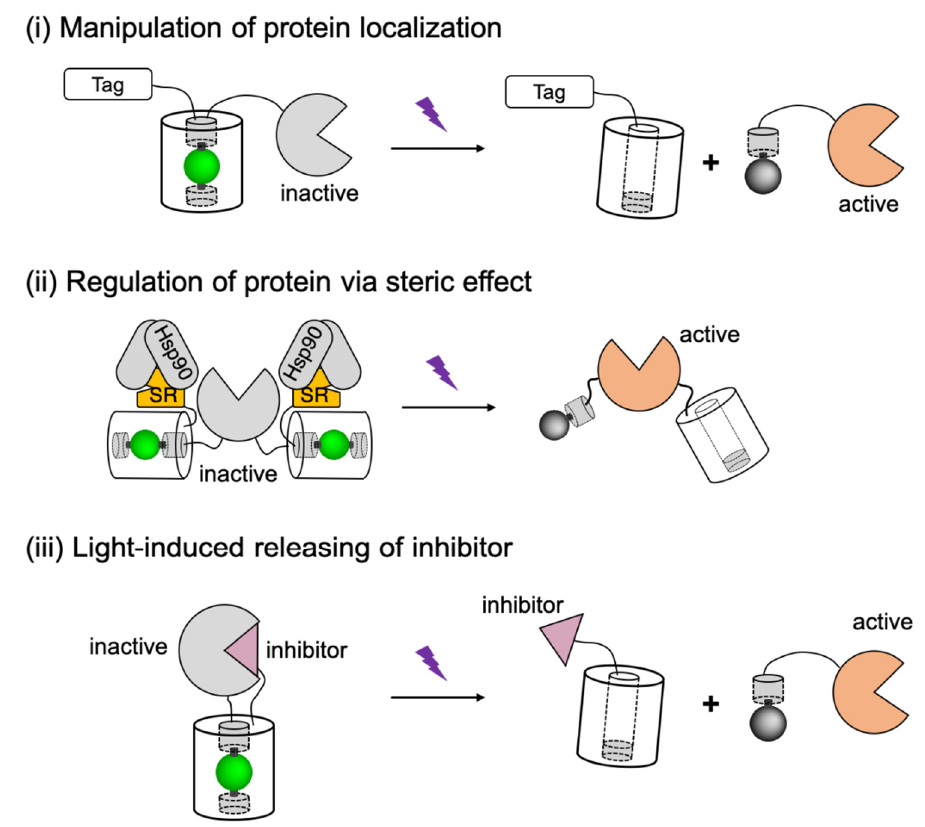
Figure 5. Schematic representations of PhoCl-based actuators design strategies. Tag, localization tag; Hsp90, heat shock protein 90; SR, steroid receptor. The schematic figure is adapted from the reported literature [58].